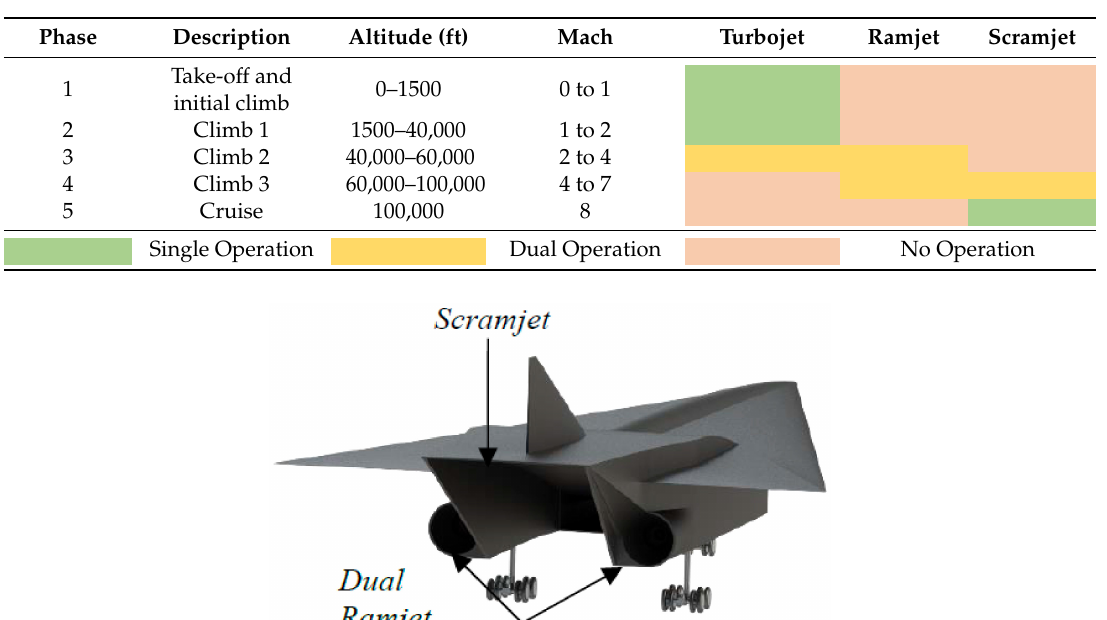
Table 1. Concept aircraft target flight profile.